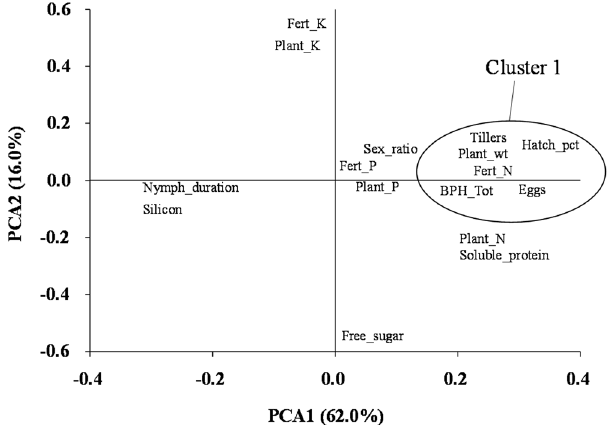
Figure 1. Physiological characteristics of rice plants and their effects on brown planthopper (BPH) fitness